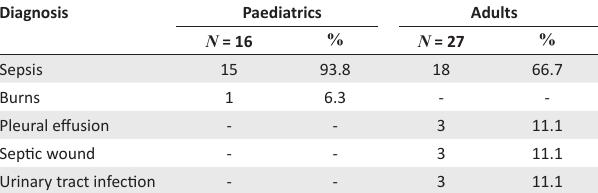
TABLE 2: Diagnosis of patients studied as recorded in patient files. Diagnosis